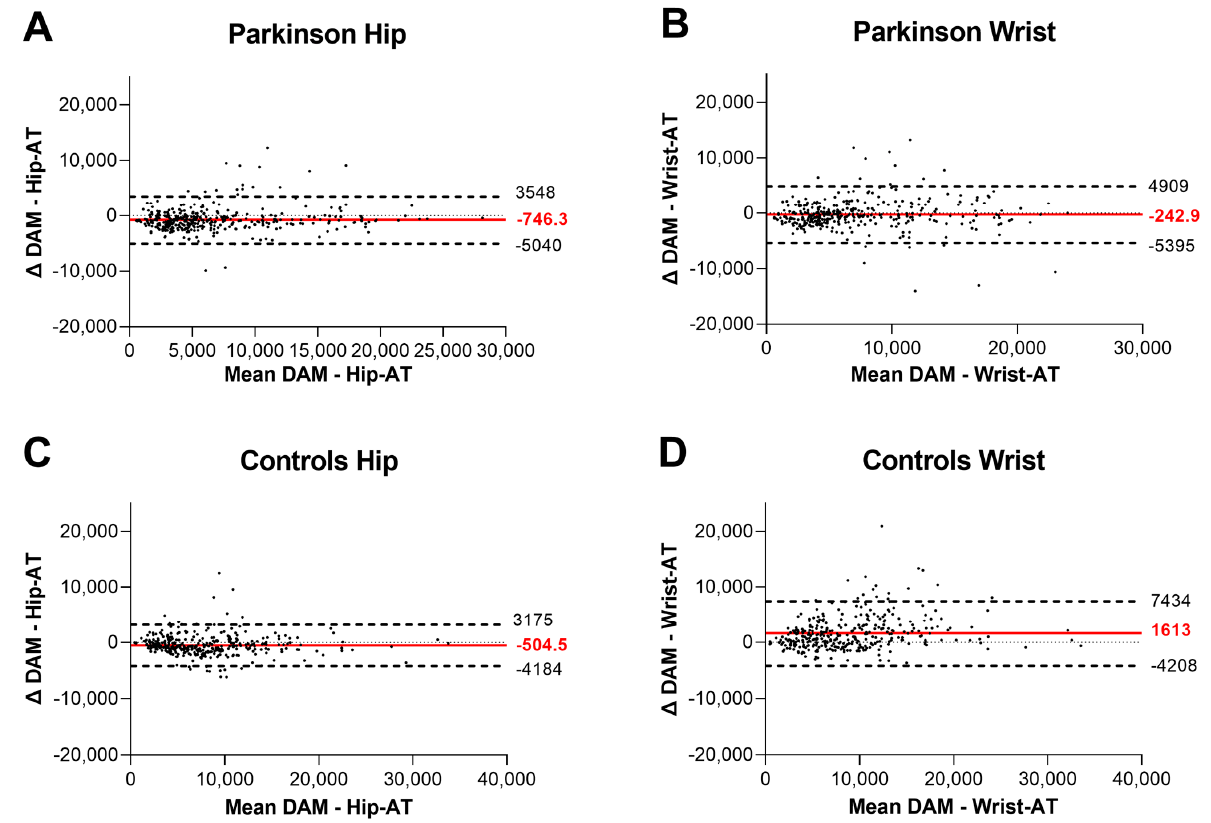
Figure 3. Bland–Altman plots with mean and 95%CI for Hip-AT and Wrist-AT compared to the DAM. Panels ( A , B ) show PwPD; panels ( C , D ) show the HC participants. Dots represent the daily steps for an individual day, irrespective of participant; small dotted line represents the zero (no difference); dashed lines represent the 95%CI with their accompanied values; full red line represents the bias in steps/day of the activity tracker compared to the DAM. Hip-AT = Fitbit Zip or Fitbit Inspire; Wrist-AT = Fitbit Alta or Fitbit Inspire; DAM = Dynaport Movemonitor.